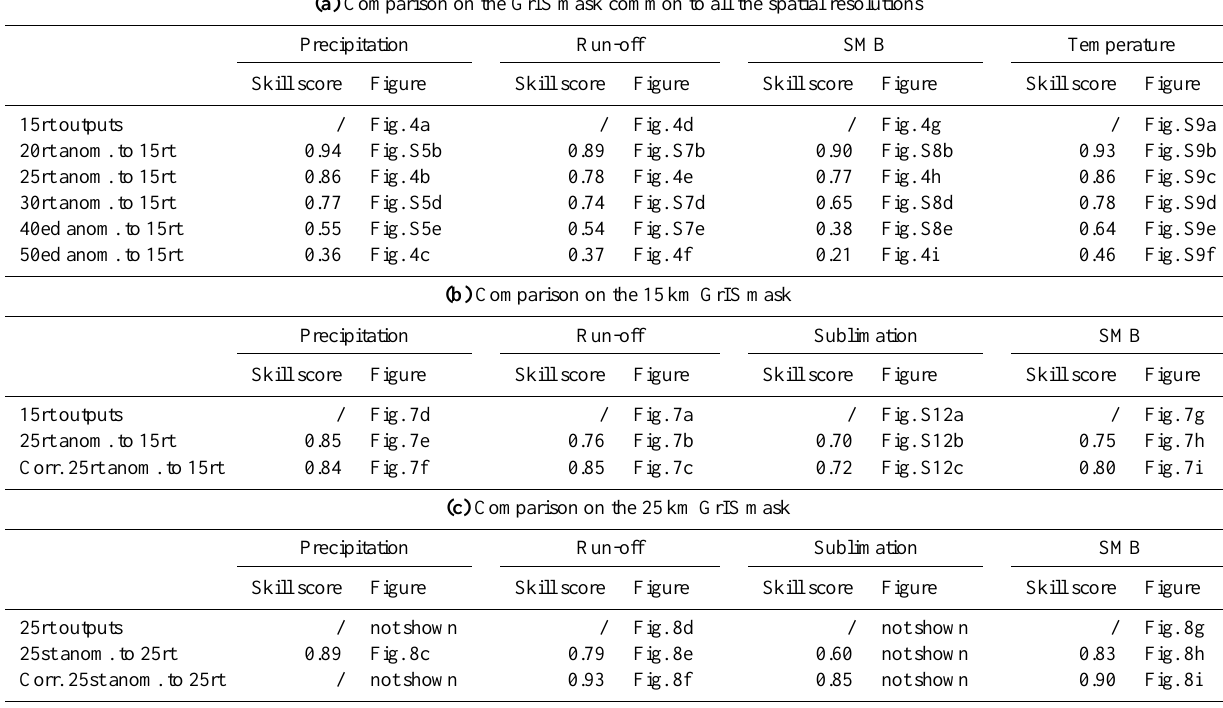
Table 3. Summary of the main skill scores calculated (a) on the GrIS mask common to all the spatial resolutions, (b) on the 15km GrIS mask, and (c) on the 25km GrIS mask.